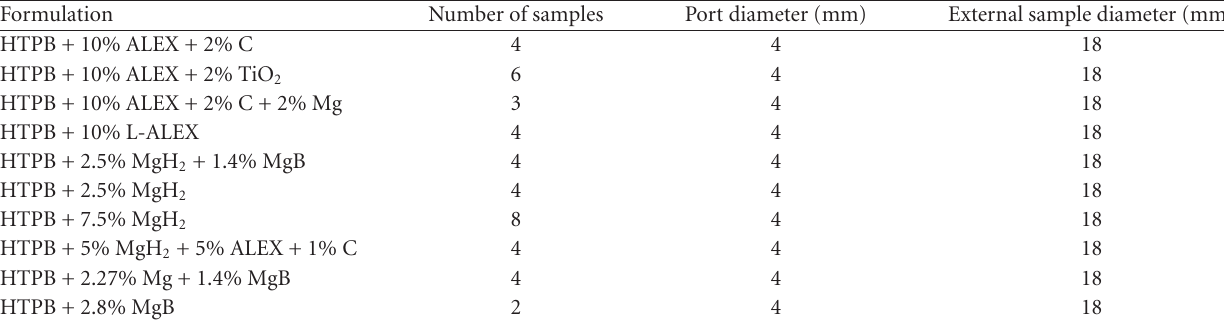
Table 4: Overview of the tested metal-loaded formulations.